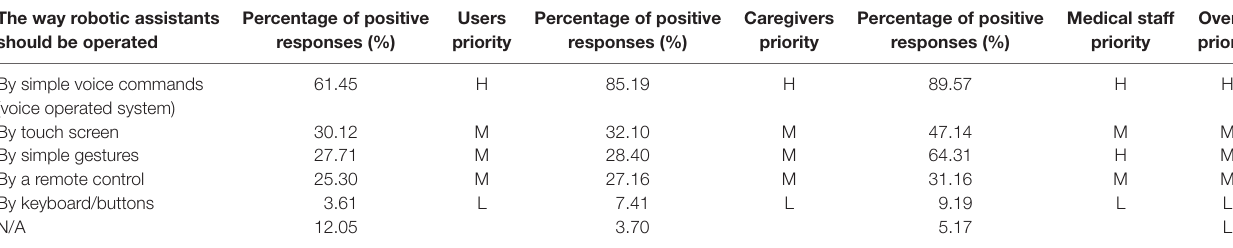
Table 4 | Prioritization of the way in which robotic assistants should be operated.